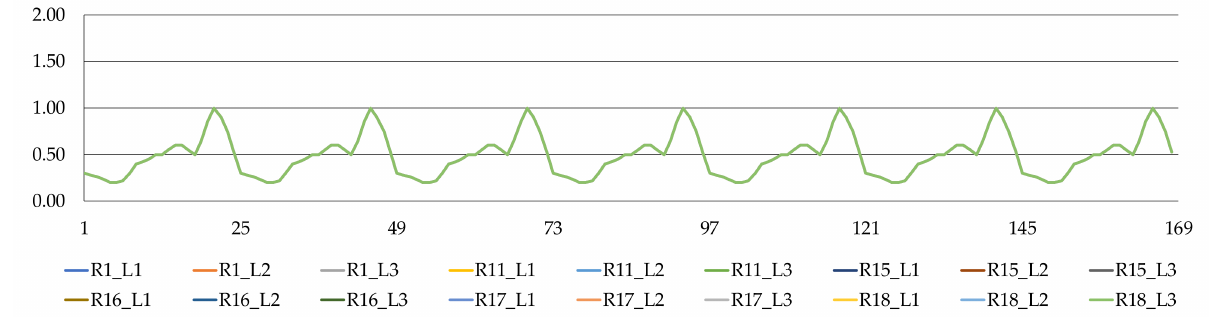
Figure 3. Weekly symmetric load profile (p.u. of peak